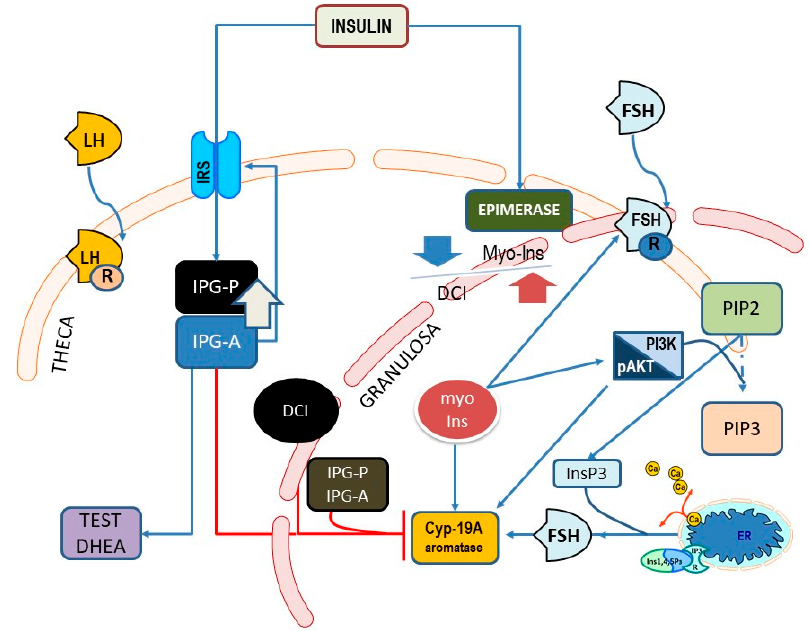
Figure 3. Main pathways showing the involvement of myo-Ins and D-chiro-Ins (DCI) upon endocrine signaling pathways in theca and granulosa cells within the ovary. Cyp-19A, aromatase; β -CAT, β -catenin; InsP3, inositol-e-phosphate; ER, endoplasmic reticulum; IP3R, InsP3-receptor; FSHr, FSH receptor; IPG, inositol phosphoglycan containing either D-chiro-Ins (P) or myo-Ins (A); IRS, insulin receptor substrate (IRS) proteins.